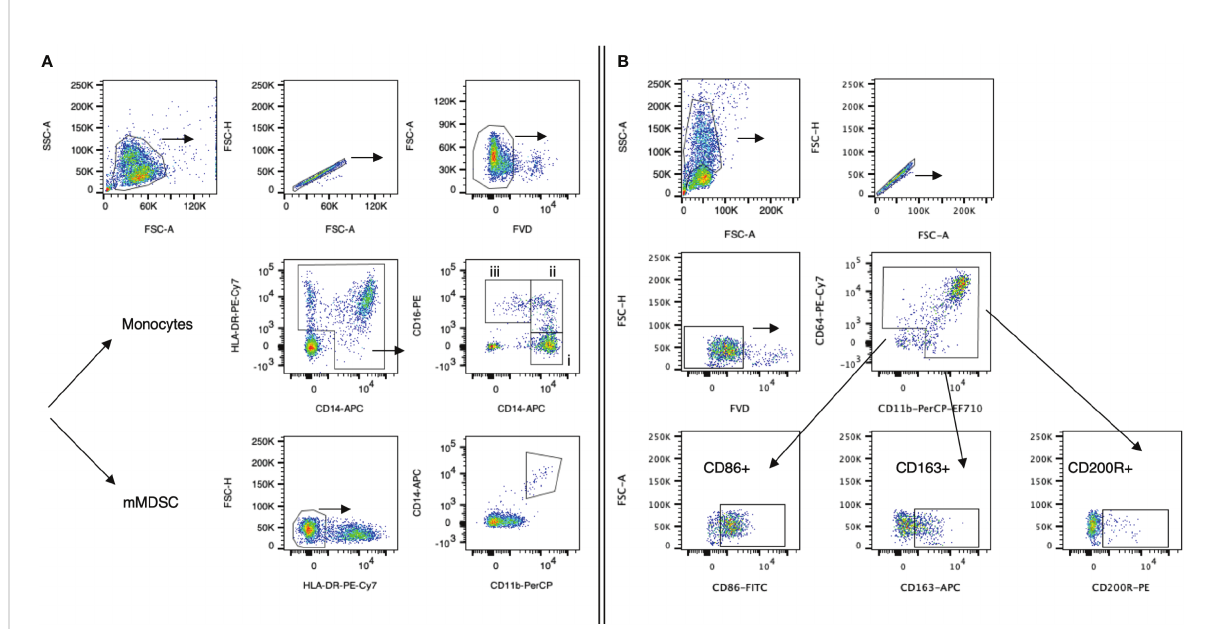
FIGURE 1 Gating strategies for myeloid cell populations. Representative dot plots from one HCC patient. (A) Panel 1: Monocytes were de fi ned as HLA- DR+CD14+ cells. Monocyte subsets (classical, intermediate, non-classical; all presented as % frequency of monocytes) were further de fi ned by their expression of CD14 and CD16: (i) classical monocytes (CD14++CD16 − ), (ii) intermediate monocyte (CD14++CD16+), and (iii) non-classical monocytes (CD14+CD16++). Monocytic MDSCs (mMDSCs) were de fi ned as HLA-DR-CD11b+CD14+ cells (% of live cells). Cells were fi xed prior to staining. (B) Panel 2: CD11b+CD64+ monocytes were further analyzed for CD86, CD163, and CD200R marker expression. Cells were not fi xed prior to staining. Following staining, cells of both panels were fi xed with 4% PFA and subsequently analyzed. FVD, Fixable Viability Dye-eFluor ®